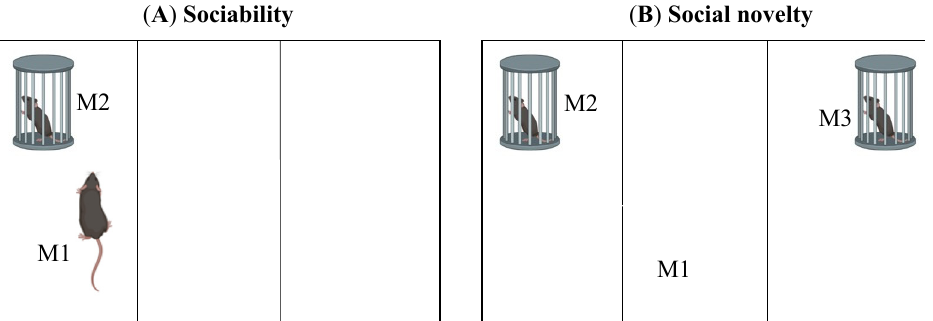
Figure 4. The social approach test. In the test for sociability ( A ), the test mouse, M1, chooses between spending time in the side with an unfamiliar mouse, M2, or in an empty side. In the test of preference for social novelty ( B ), the test mouse, M1, is now given a preference choice between the first mouse, M2, and a newly introduced unfamiliar mouse, M3. Created with Biorender.com.